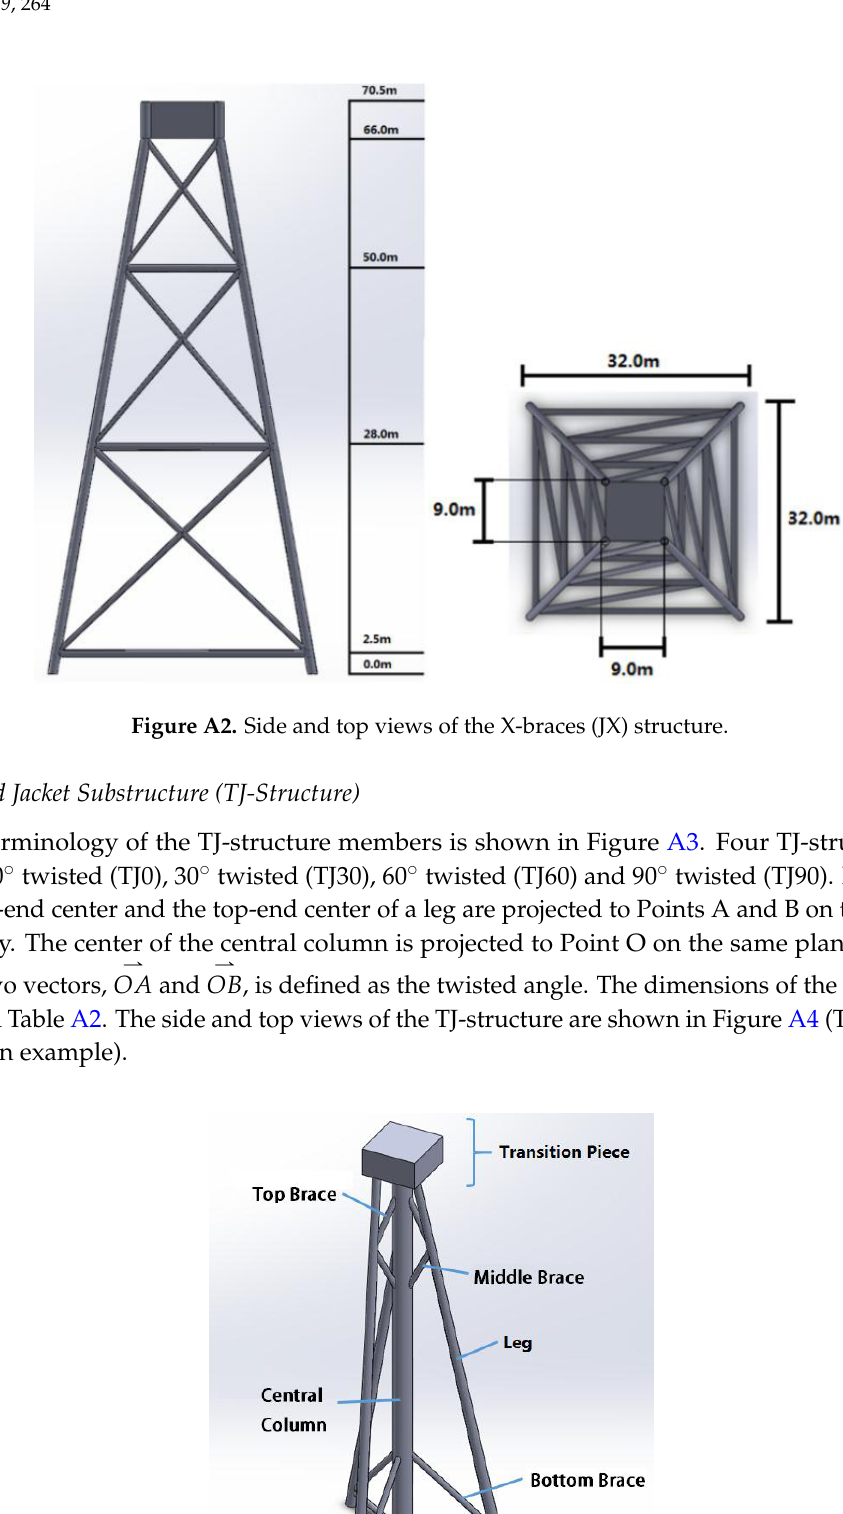
Figure A4. Illustration for the definition of the twisted angle. Table A2. Specification of four TJ-structures. Twisted Jacket Structure Jacket Structure